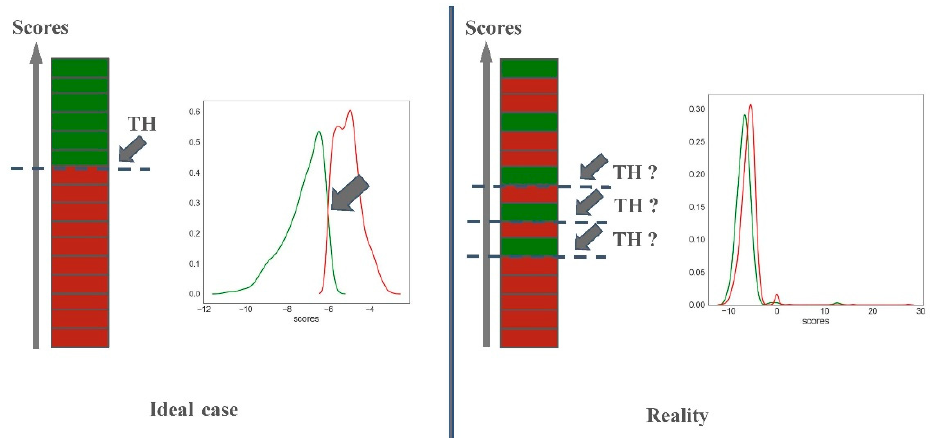
Figure 4. Docking scores distribution between B (green) and NB compounds (red) of the EPA database .